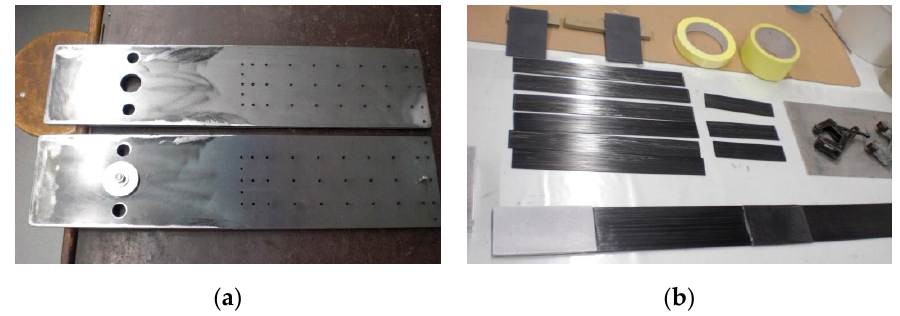
Figure 5. Elements of the steel plates ( a ) and CFRP strips ( b ) prepared for bonding.